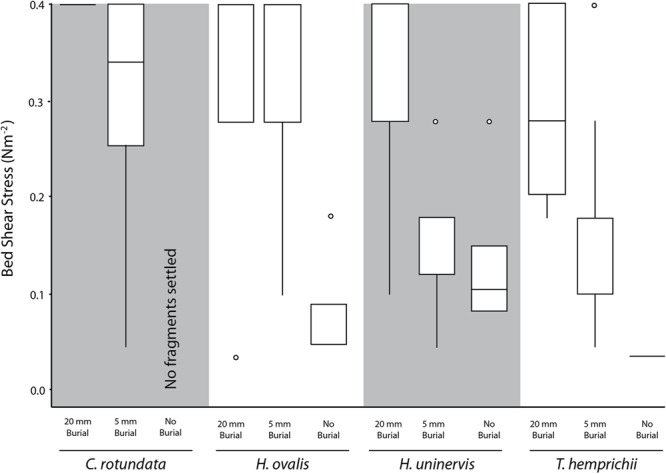
Box plot of the current-generated bed shear stress (N m-2) needed to dislodge fragments of different species under each burial treatment. Midline represents 50% quartile, and top and bottom of each box represent 75 and 25% quartiles, respectively.